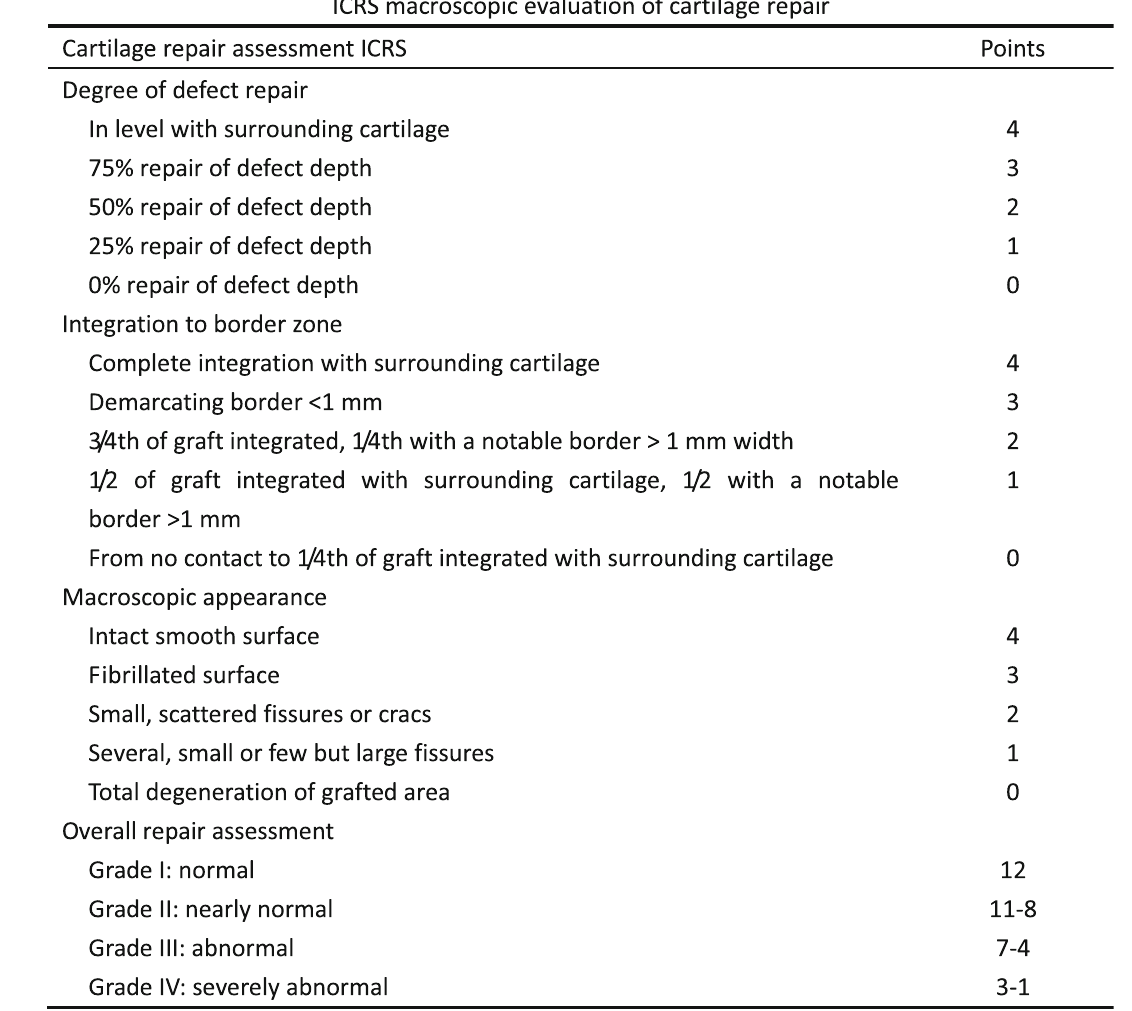
Table 1 ICRS macroscopic evaluation of cartilage